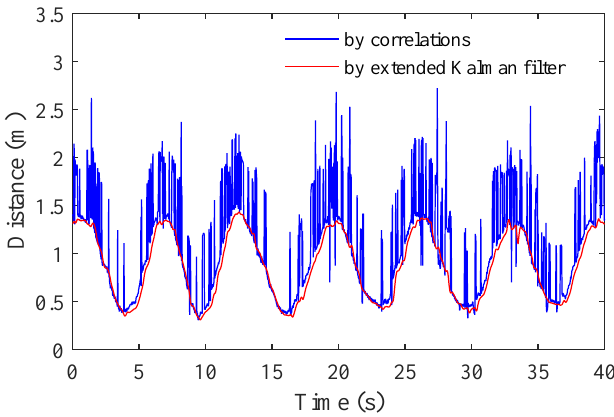
Figure 4. Large body movements τ a estimated by two